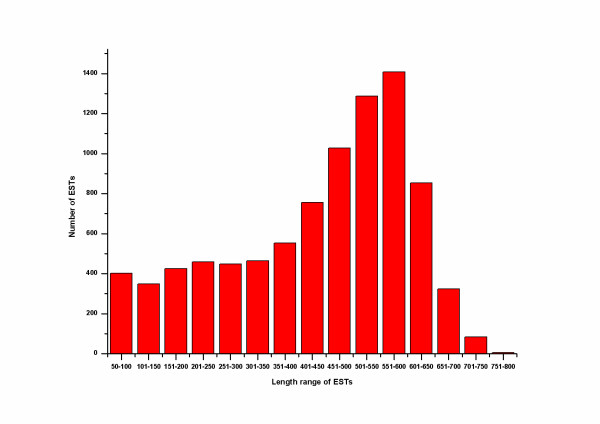
The distribution of the reads length of the ESTs. A total of 8696 ESTs were generated in the present study. Abscissa (50 bp) is the length of sequences, while the Y-coordinate is the number of ESTs. A large fraction of ESTs is between 350 and 650 bp.